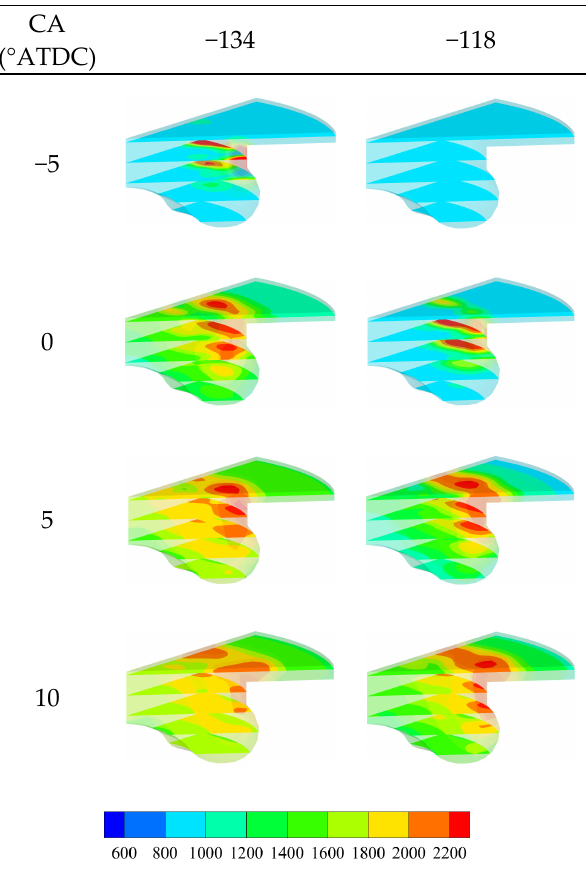
Figure 17. Simulated evolution of spatial temperature (K) distributions under conditions of IVC timings of − 134° and − 118 °ATDC.